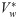
A learning mechanism that leads to prospective coding.A The signal to be predicted (target input) originates from the green neuron and depolarizes the black neuron (gray trace) such that it spikes (black lines). The synaptic connection between a blue neuron and the black neuron is strengthened if pre- and postsynaptic spikes lie within the red plasticity window of potentiation, which is slightly broader than a typical postsynaptic potential. B Due to the strengthened connection (red circle), the black neuron spikes already before the target input arrives. Since earlier presynaptic spikes now also lie within the potentiating plasticity window, the activity of the black neuron will be anticipated earlier, giving rise to prospective coding. C A spiking neuron receives input through plastic dendritic synapses with strengths wi and an input I through static (i.e. non-plastic) synapses. The somatic membrane potential U is well approximated by the sum of attenuated dendritic input Vw* and attenuated somatic input U*.